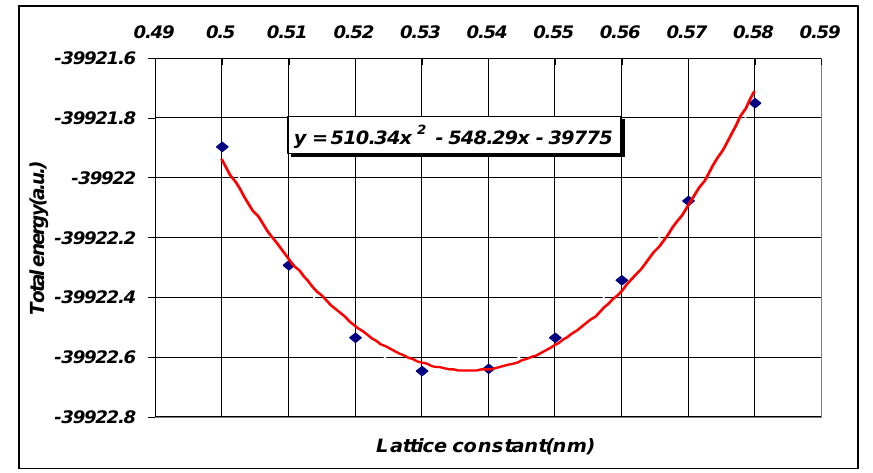
Fig. 1: Total energy of 54 atoms of Al As